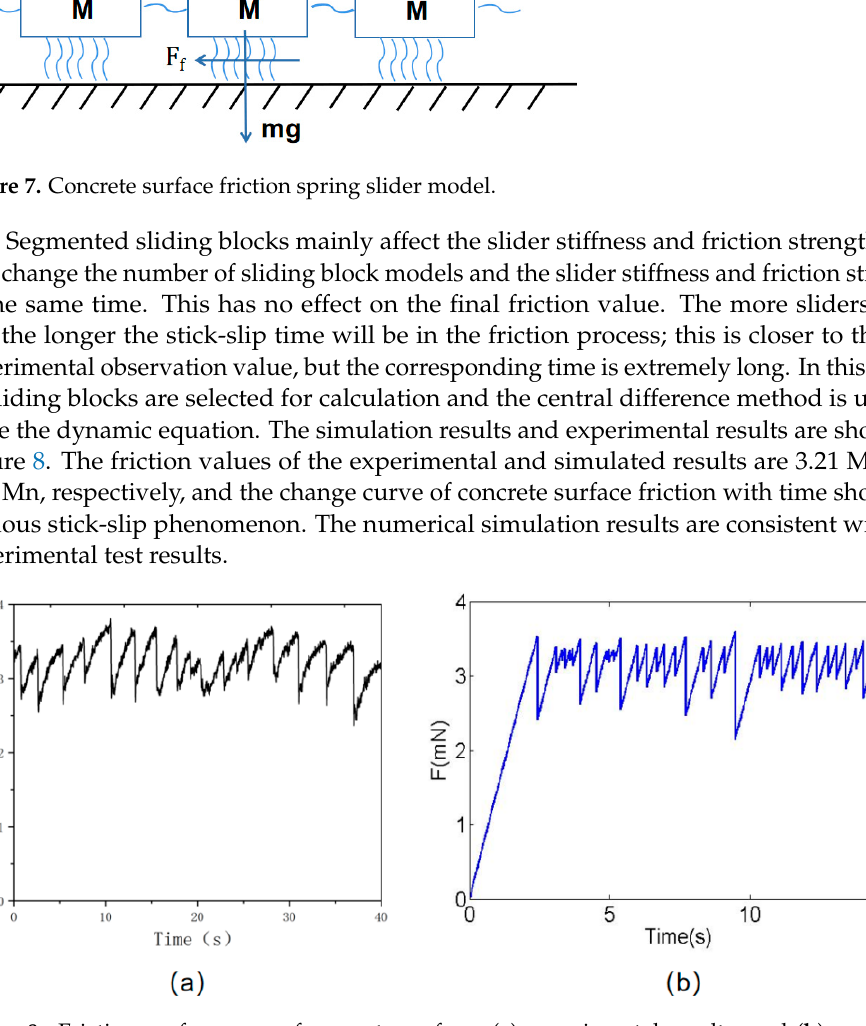
Figure 8. Friction performance of concrete surface: ( a ) experimental results; and ( b ) numerical simulation results.